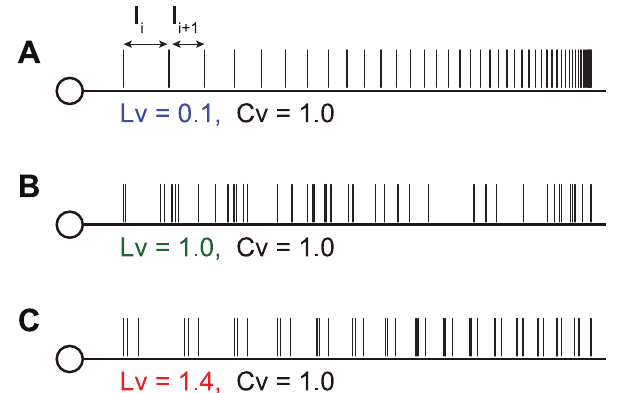
Figure 1. Spike sequences that have identical sets of inter- spike intervals. Intervals are aligned (A) in a regular order, (B) randomly, and (C) alternating between short and long.